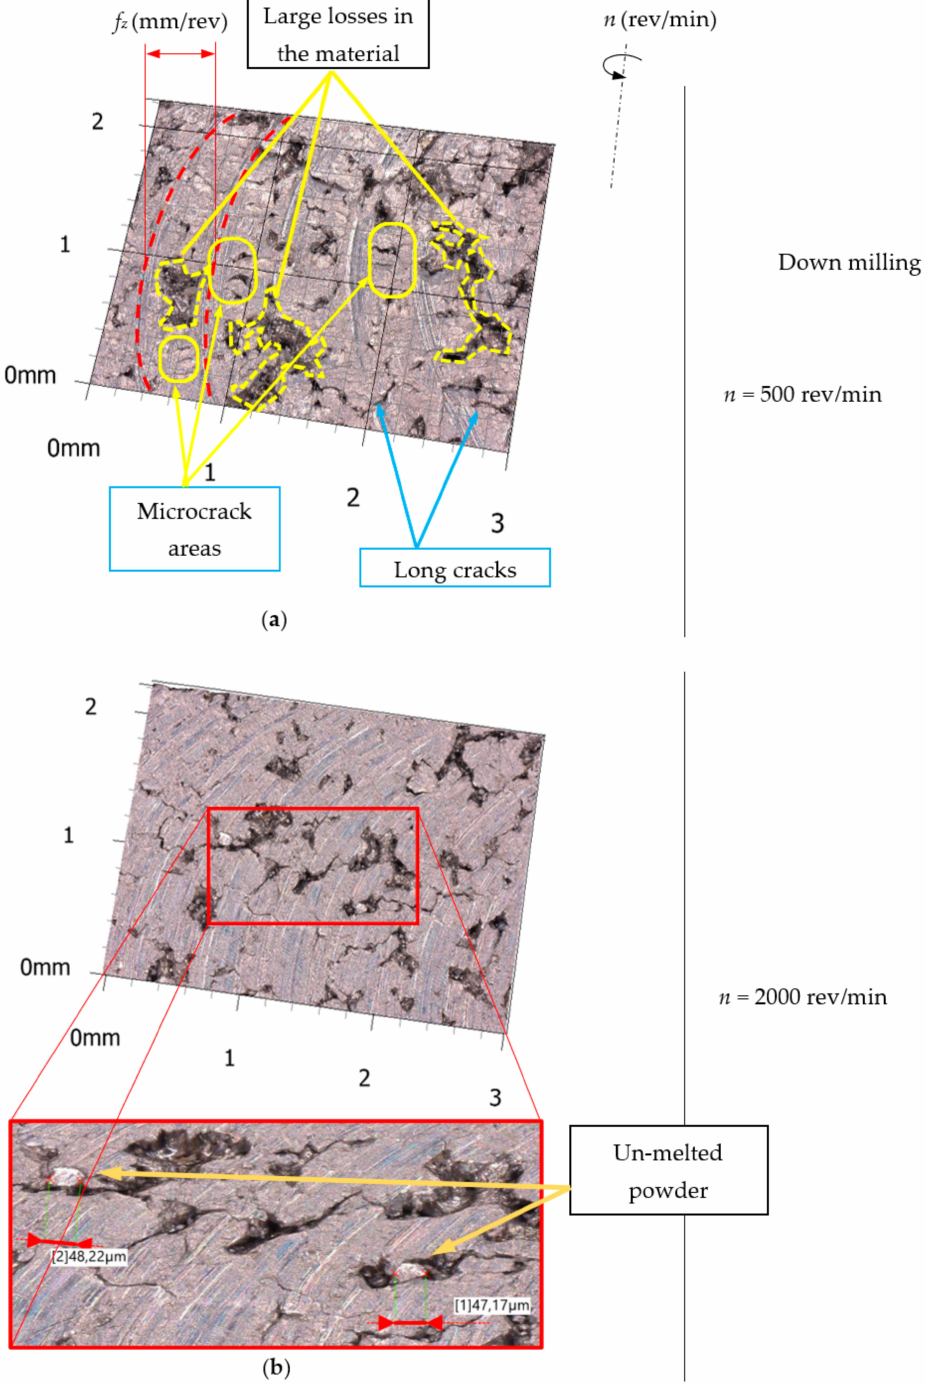
Figure 3. Example of 3D microscope surface measurement after down milling. ( a ) n = 500 rev/min. ( b ) n = 2000